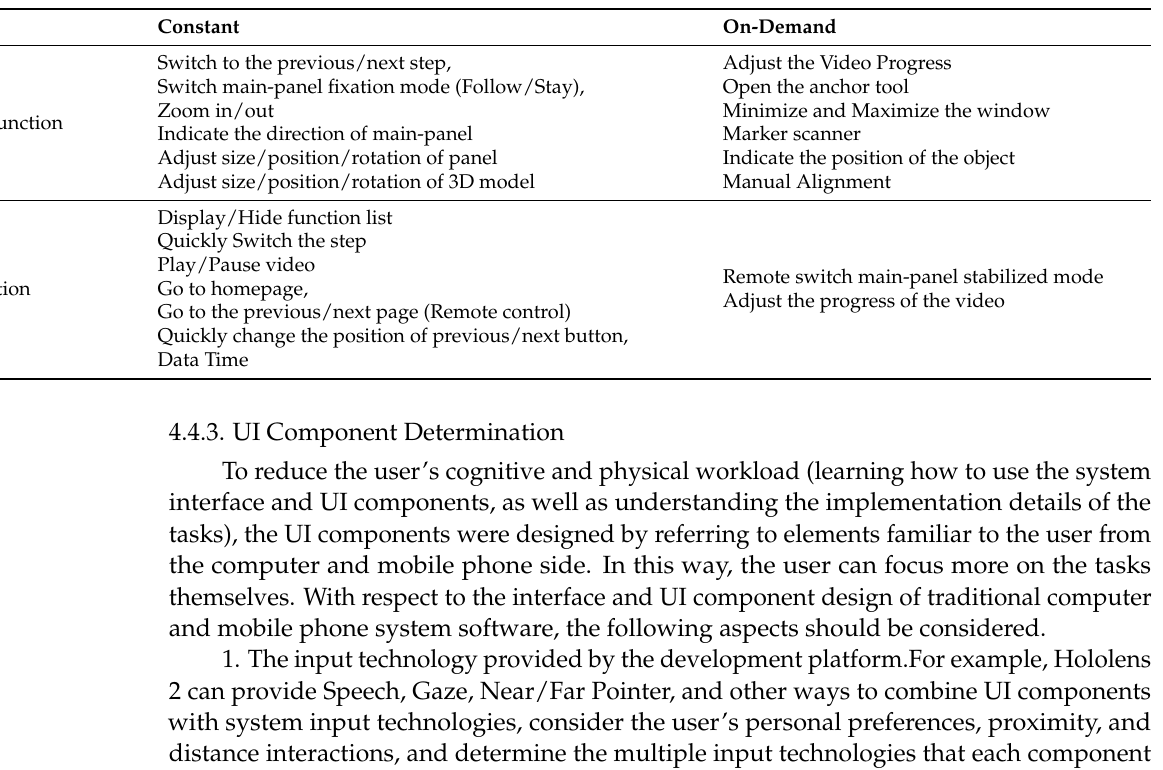
Table 2. Function